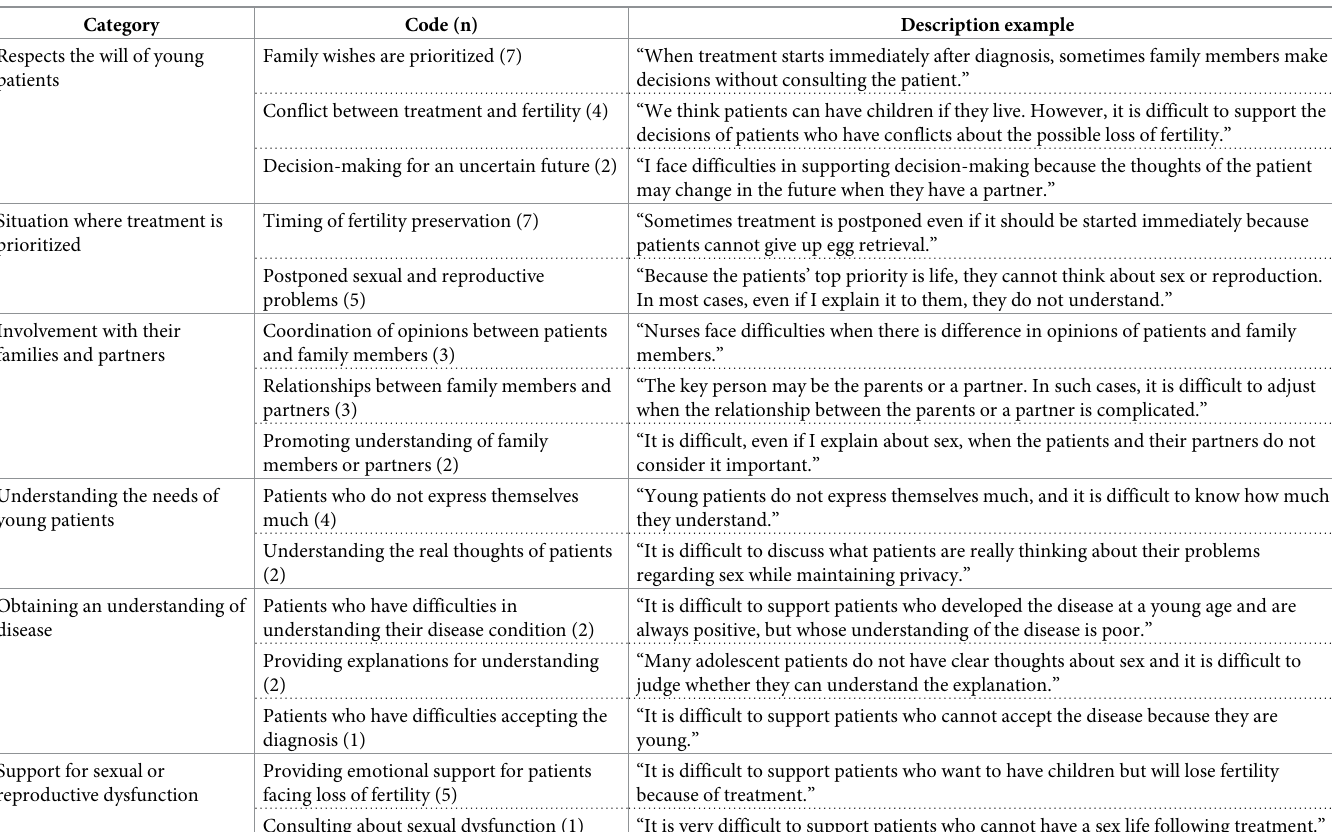
Table 4. Difficulties in providing support due to patient characteristics (free descriptions). n =